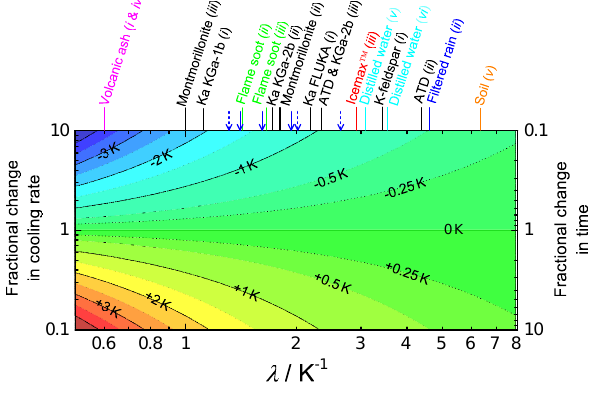
Figure 11. The shift in temperature β K that will result from a frac- tional change in cooling rate or residence time as a function of λ . Estimated values include those determined from (i) this study, (ii) Wright et al. (2013) cooling experiments, (iii) Wright et al. (2013) freeze–thaw experiments, (iv) Fornea et al. (2009), (v) Vali (2008), and (vi) Vali and Stansbury (1966). INP samples are colour coded depending on INP type. Blue (solid and dashed) arrows correspond to rain samples (unfiltered and filtered) from the freeze–thaw exper- iments presented in Wright et al.